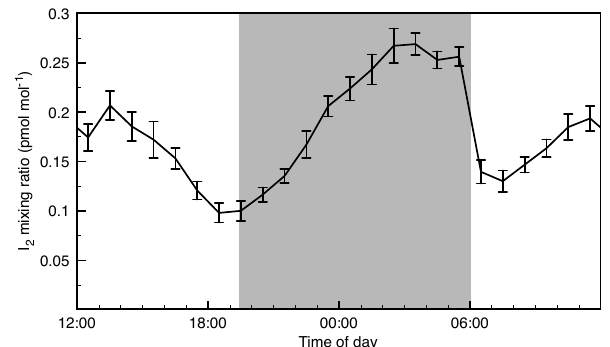
Fig. 5. Mean hourly binned I 2 mixing ratios measured over three weeks at CVAO in 2007. Error bars are one standard error. Shaded area represents nighttime hours. The mean observed solar cycle over the measurement period was used to assign sunrise and